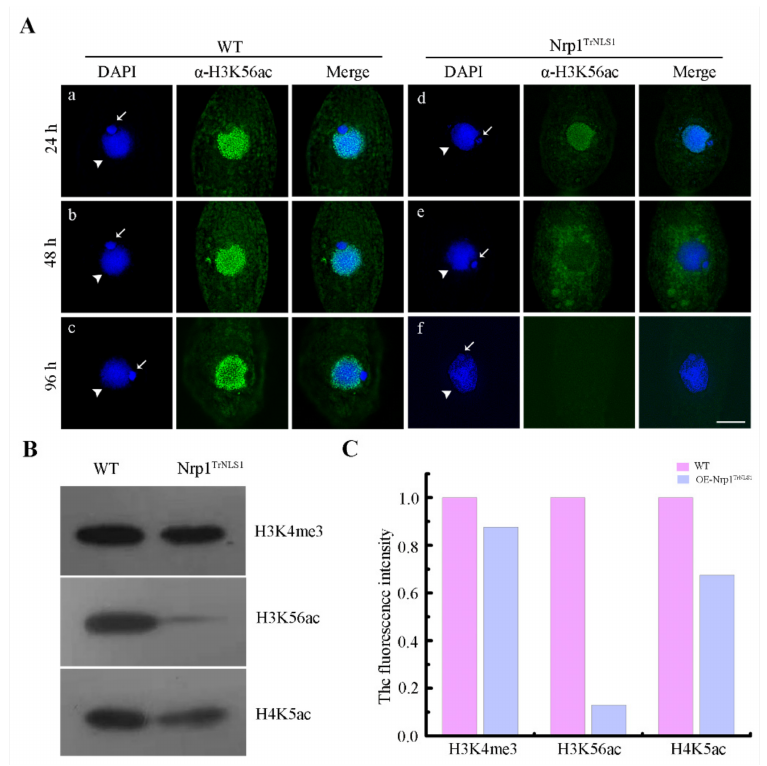
Figure 4. Nrp1 mutation leads to reductions in H3K56ac and H4K5ac. ( A ) Indirect immunofluores- cence localization of H3K56ac and H4K5ac. The cells were induced with 0.3 µ g/mL Cd 2+ for 24, 48, and 96 h. The primary antibody was histone H3K56ac or H4K5ac rabbit polyclonal antibody, and the secondary antibody was FITC-conjugated goat anti-rabbit. White arrows indicate MIC, while white arrowheads indicate MAC. Scale bar, 10 µ m. ( B ) Western blot analysis of H3K4me3, H3K56ac, and H4K5ac. Histone extracts prepared from WT and Nrp1 TrNLS1 cells at the vegetative growth stage were induced with 0.3 µ g/mL Cd 2+ for 96 h. The extracted histone samples were separated by 15% SDS–PAGE. The gels were transferred to polyvinylidene difluoride membranes and probed by using anti-H3K4me3, H3K56ac, and H4K5ac antibodies. ( C ) The intensities of H3K4me3, H3K56ac, and H4K5ac were obtained by ImageJ software. The fluorescence of H3K4me3, H3K56ac, and H4K5ac in WT cells was arbitrarily set as 1, and the Nrp1 TrNLS1 mutation fluorescence was normalized to signal from WT